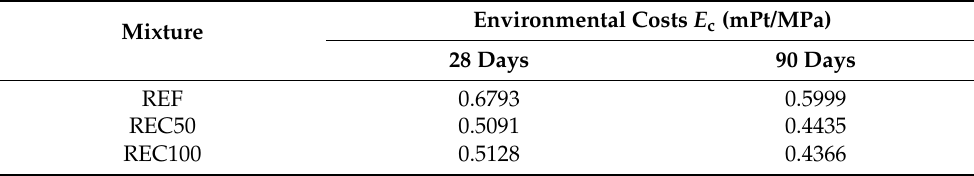
Figure 14. Endpoint categories comparison of the crushed pavements recycling scenarios. Table 6. Results of the combined environmental/functional performance.